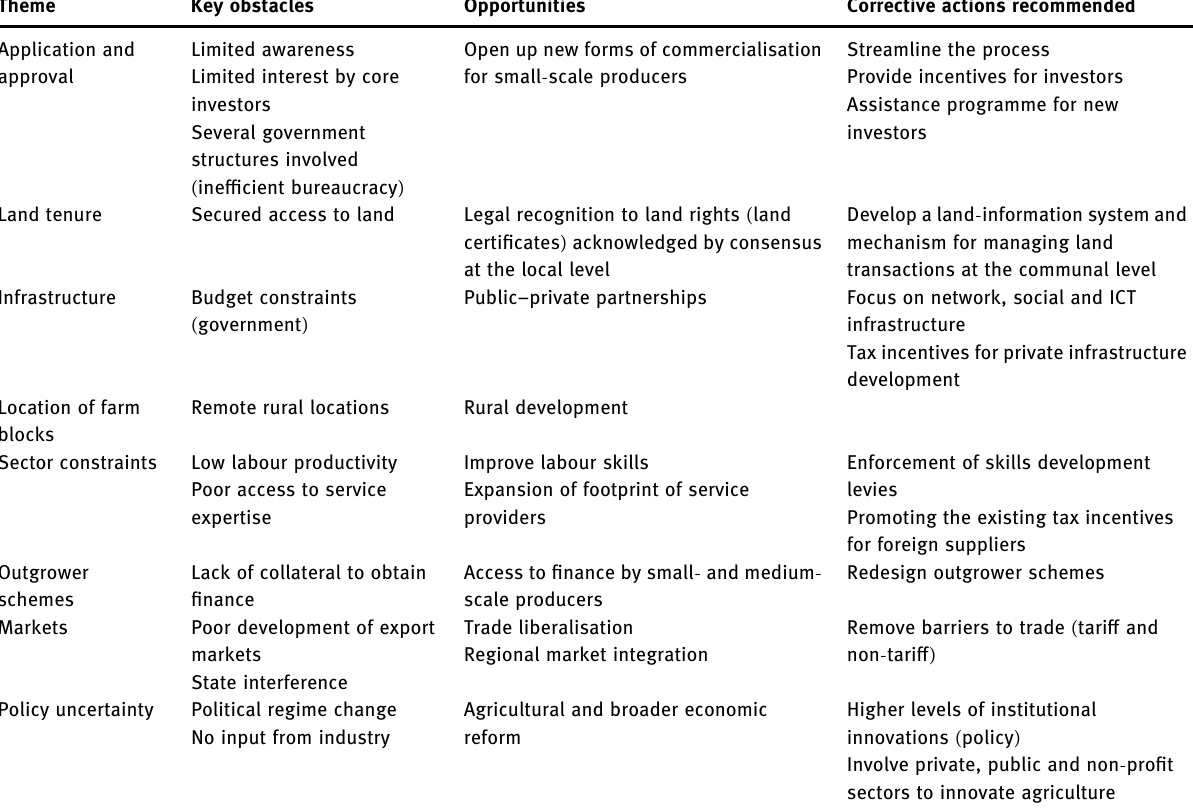
Table 3: Summary of the key fi ndings Theme Key